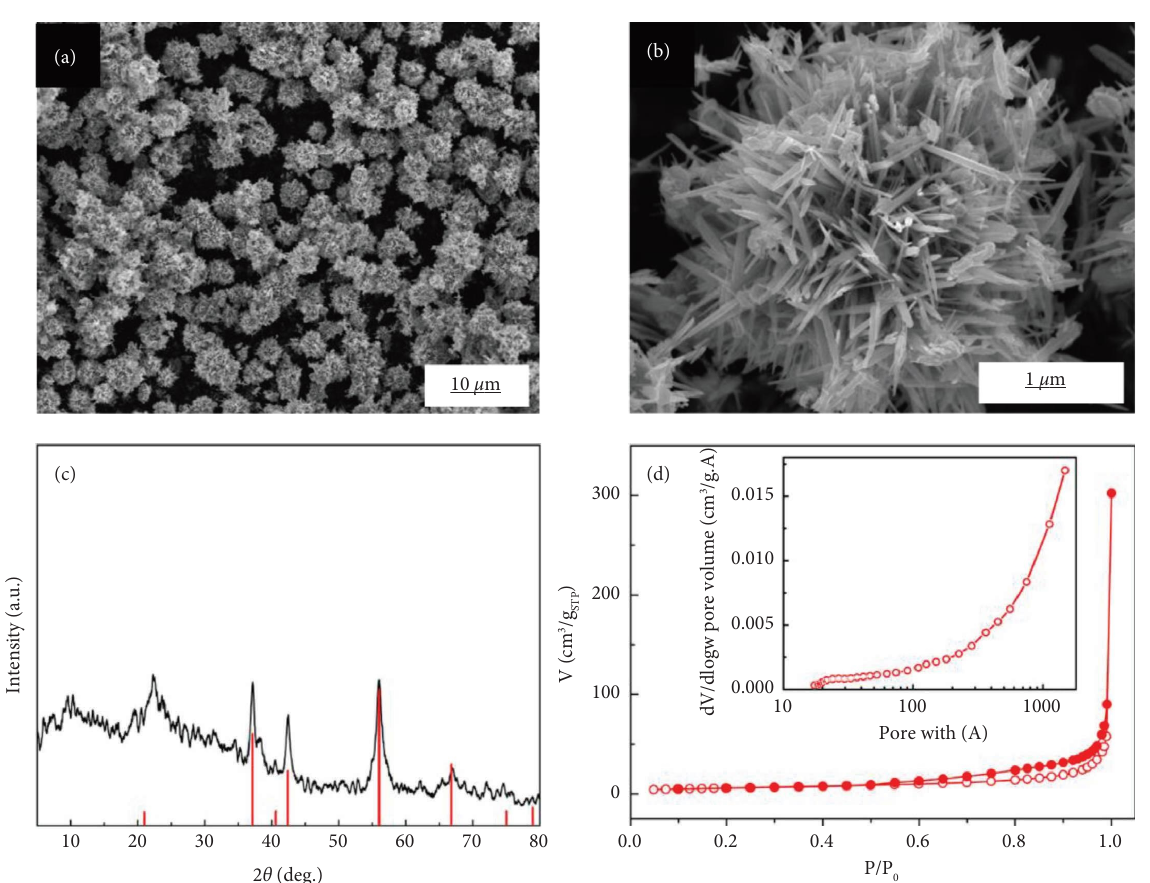
Figure 1: (a) Low and (b) high resolution SEM images, (c) XRD pattern, (d) nitrogen adsorption-desorption isotherms and pore size distribution plot (inset) of the synthesized MnO 2 microfowers.